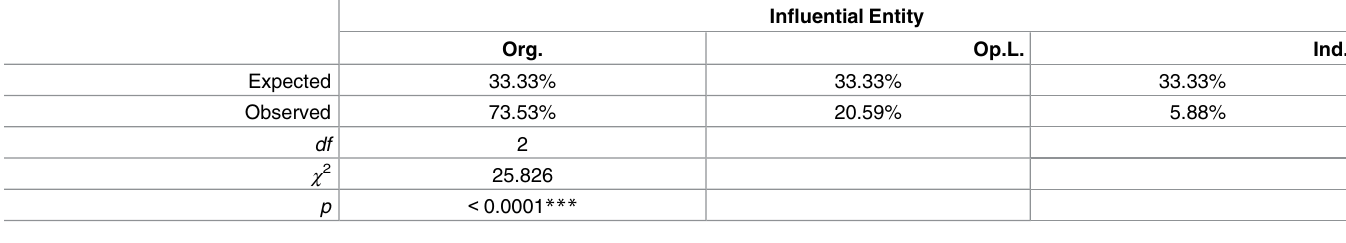
Table 3. Comparison of diffusion flow from organizations, opinion leaders, and individuals to individuals. Results from Pearson’s Chi-squareTest